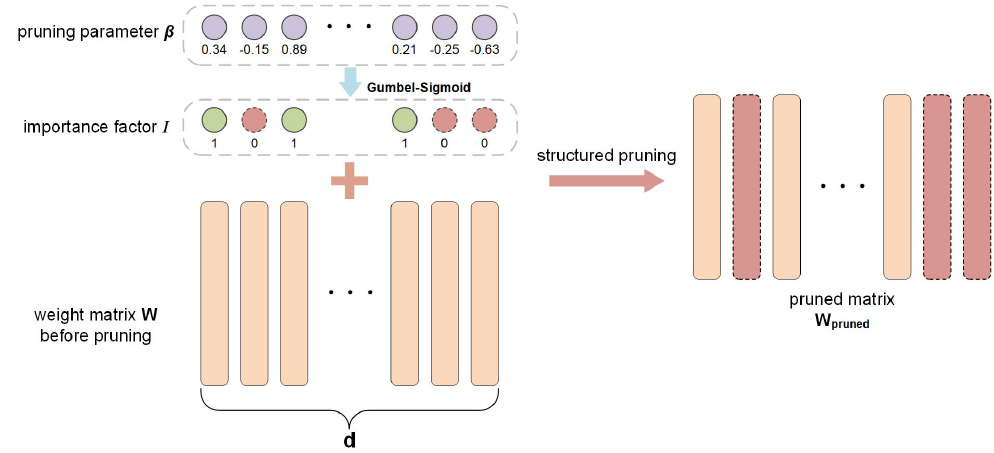
Figure 3. The differentiable structured pruning criterion. With a Gumbel-Sigmoid activation, DSP employs a soften one-hot vector to guide the pruning. 1 corresponds to remained parameters and 0 corresponds to removed